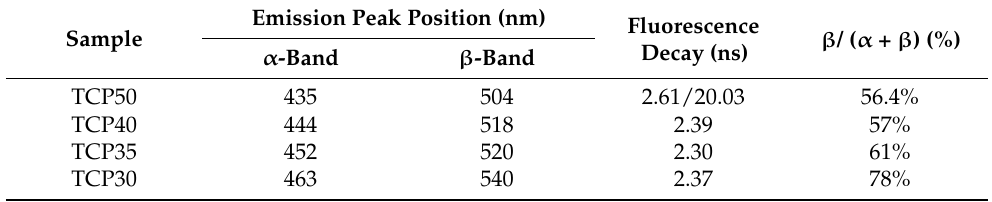
Table 1. Emission peak performance parameters of TCP glasses with different Sn/P